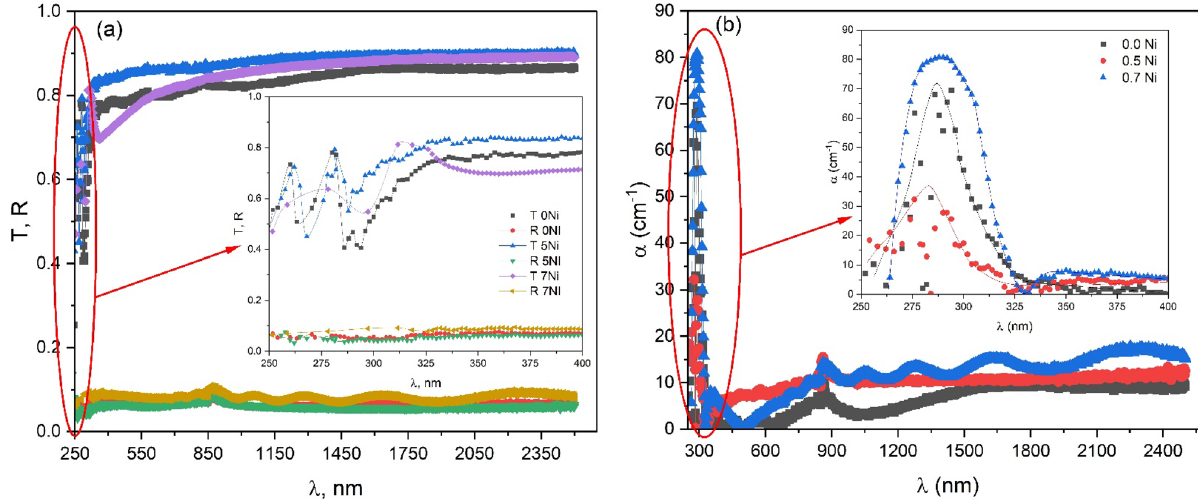
Figure 4. ( a ) The optical transmittance and reflectance spectra, and ( b ) the absorption coefficient of tested films as a function of